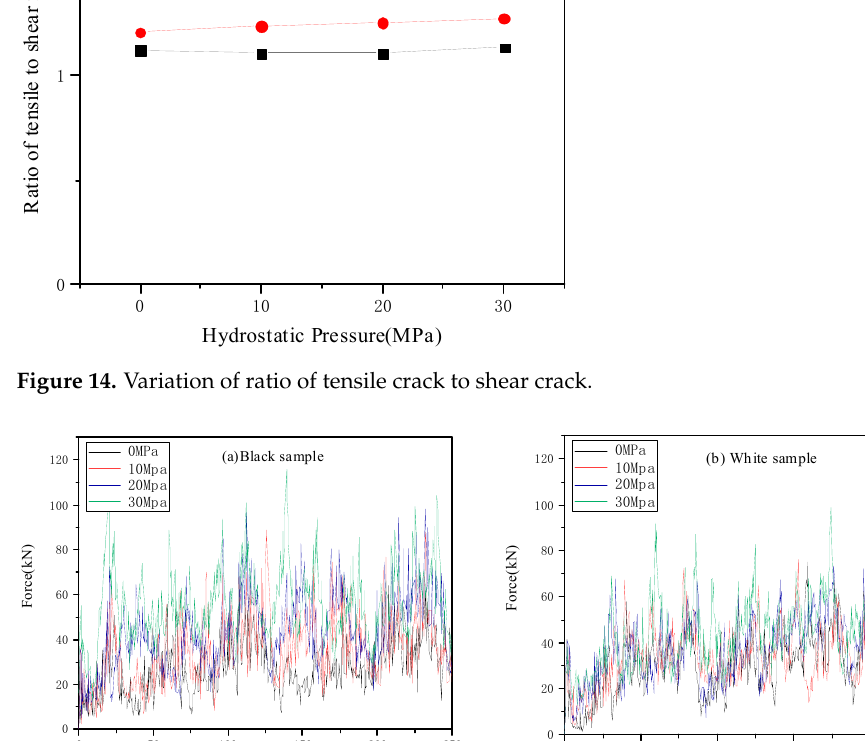
Figure 15. Cutting force variation under different ambient pressure.